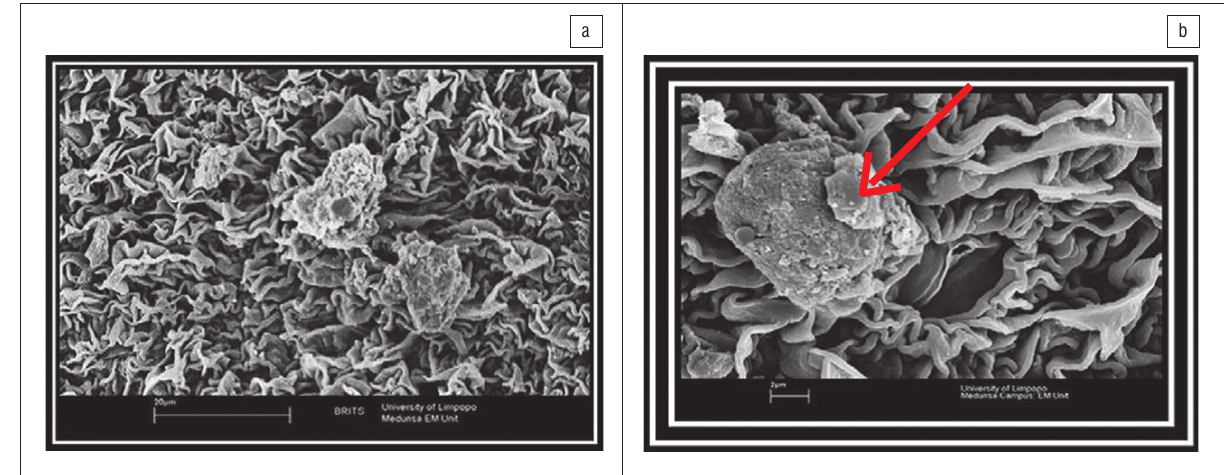
Figure 1: Presence of pollutants around the stomata of leaves collected for a study conducted in Pretoria, South Africa at (a) 2000X magnification and (b) 3000X magnification. 9 The stomata are the bean-shaped structures and the arrow is pointing to the pollutants around them.